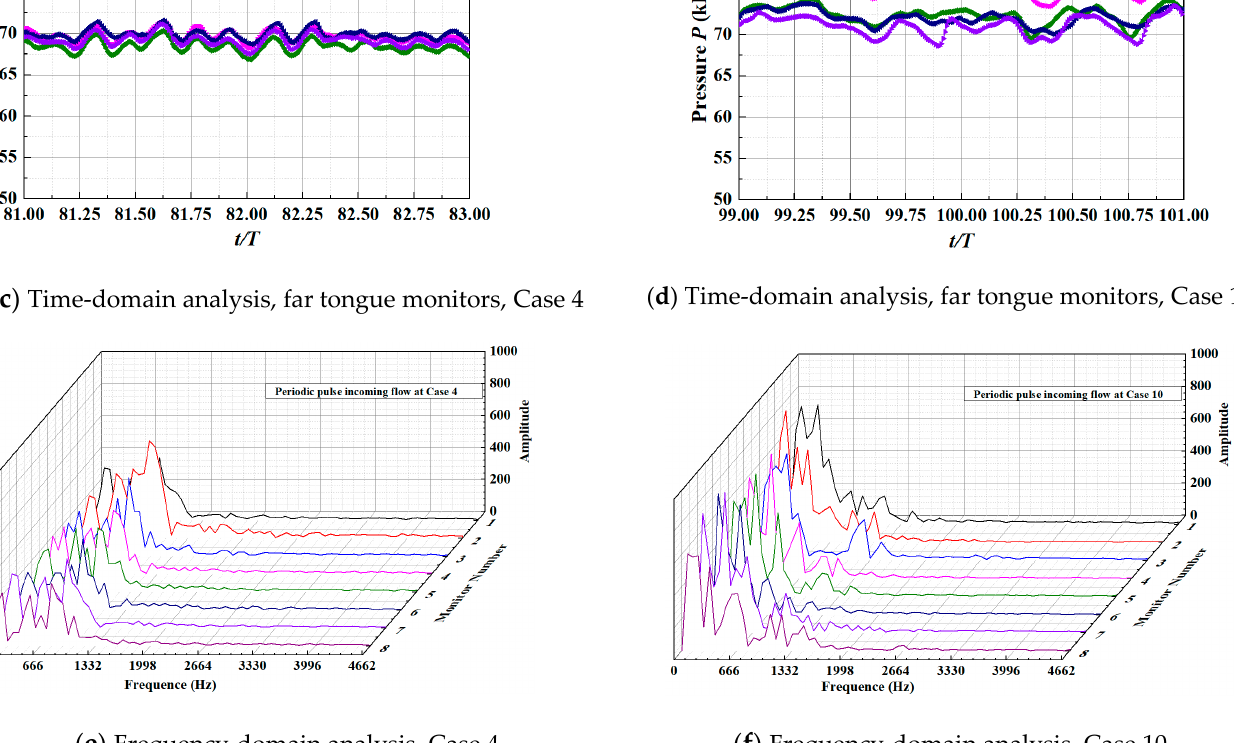
Figure 20. Time-domain and frequency-domain analysis of pressure pulsation for Case 4 (first column) and Case 10 (second column).